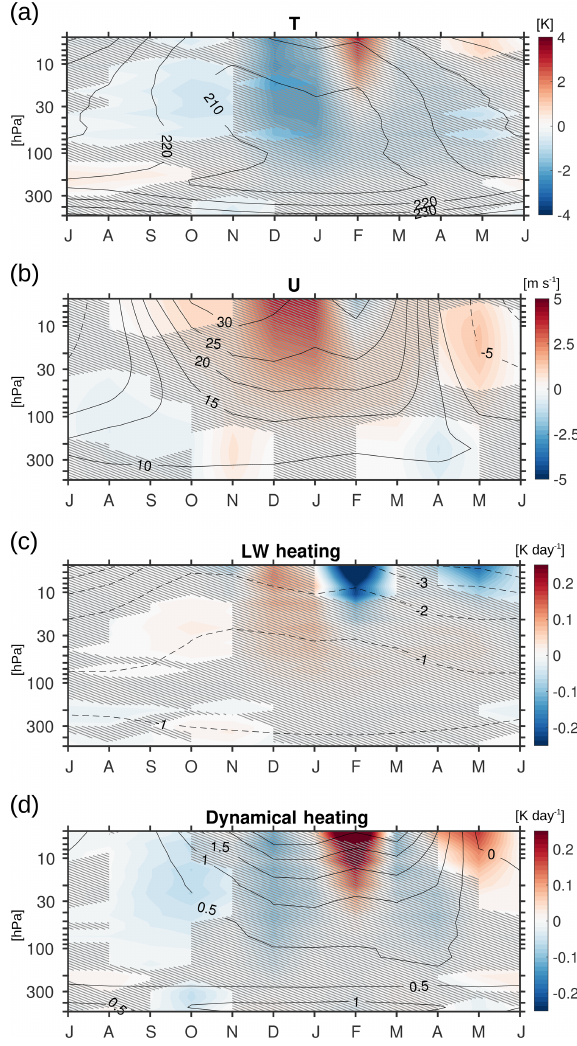
Figure 6. Same as Fig. 4 but using Chem OFF 3D for comparison with Chem